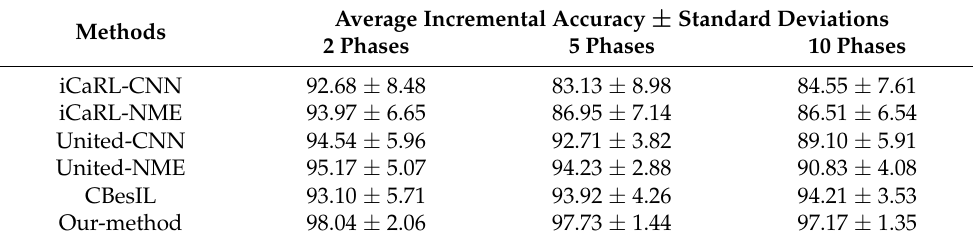
Table 2. Average incremental accuracy for 0ur-method vs. state of the art (average incremental accuracy ± standard deviations).